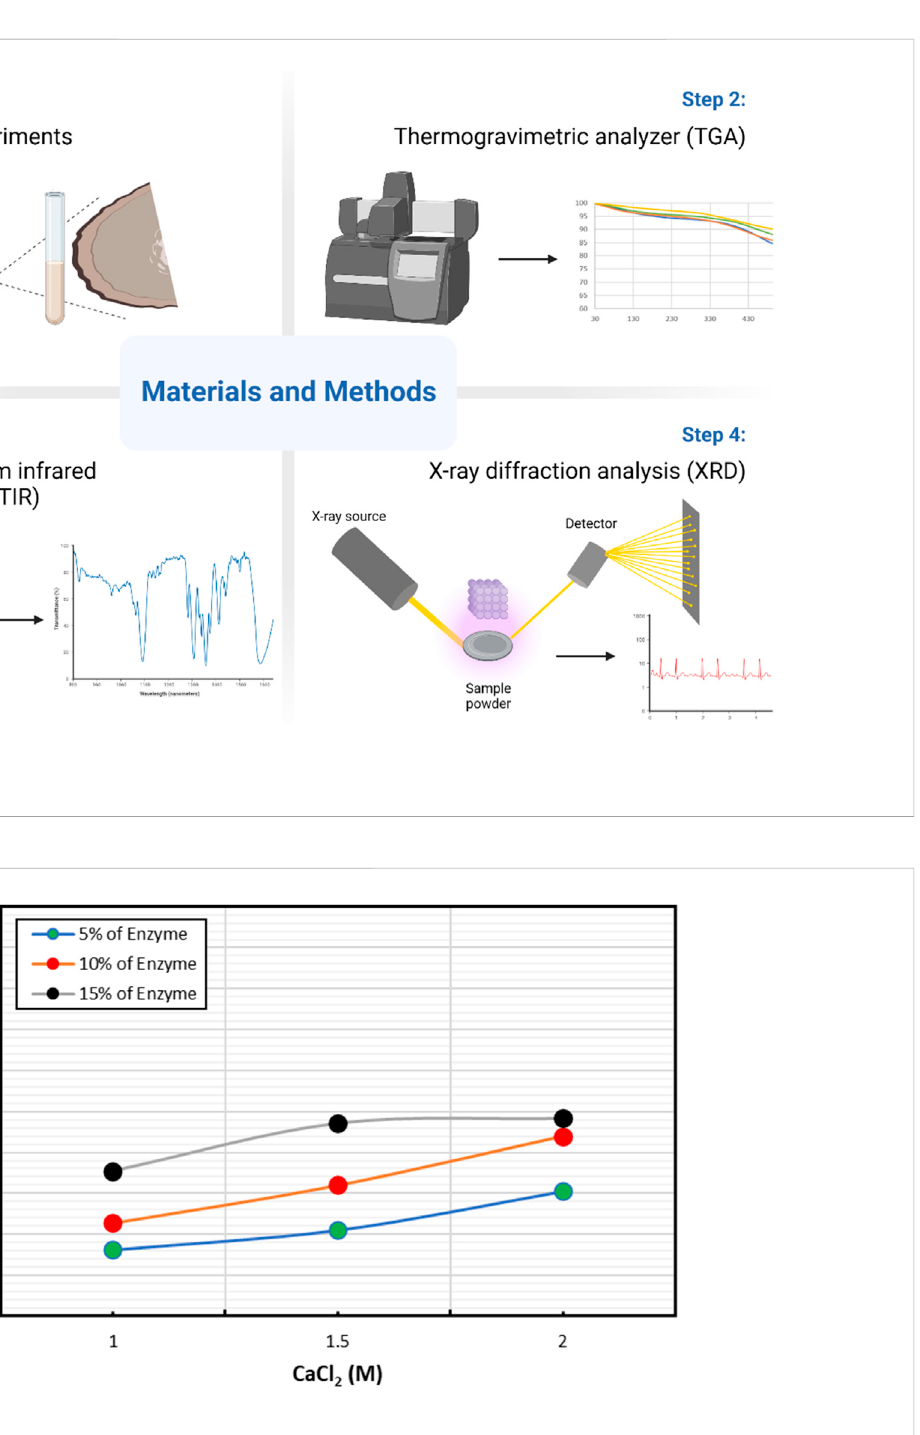
Evaluation of enzyme concentration sensitivity with CaCO 3 precipitation